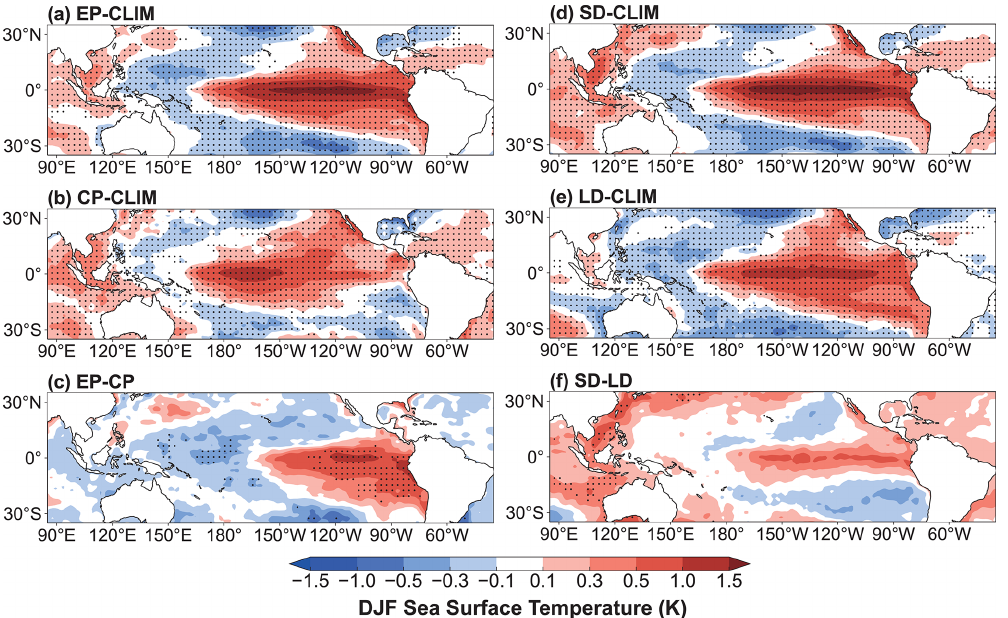
Figure 1. Composite differences in DJF mean SST ( ◦ ) between (a) EP, (b) CP, (d) SD, and (e) LD El Niño events and climatological mean over 1870–2017, (c) between EP and CP, and (f) between SD and LD El Niño events. Statistically significant differences at 99% from a two-tailed t test are